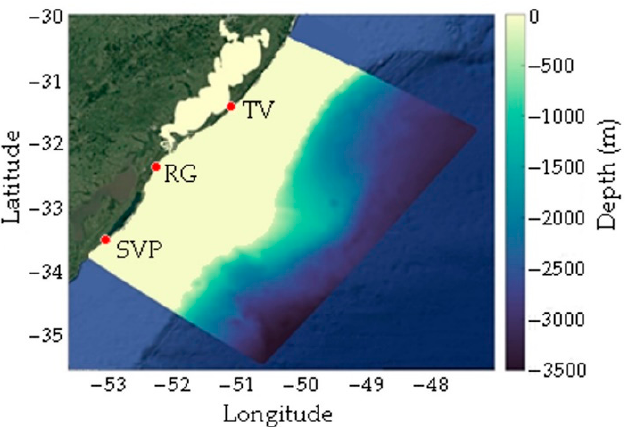
Figure 1. Computational domain used in the TOMAWAC software to obtain the sea state data.